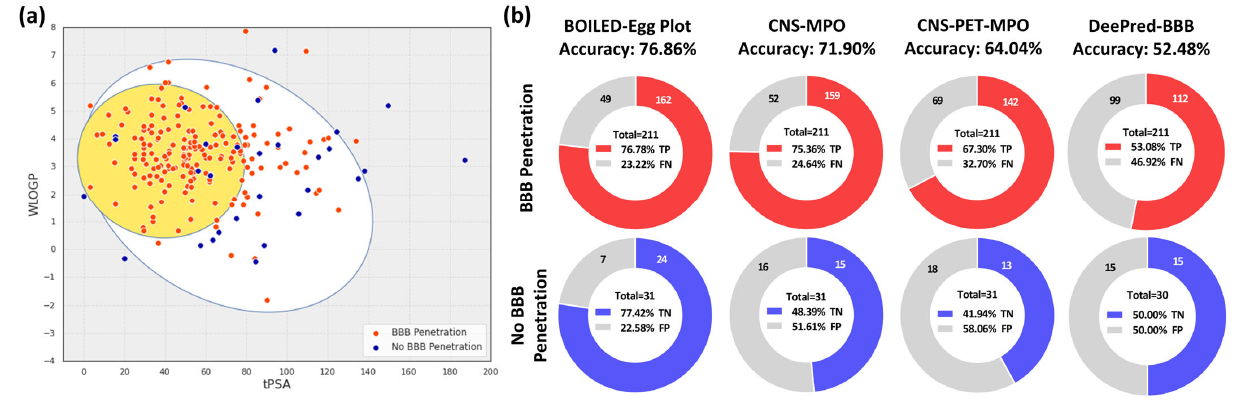
Figure 5. ( a ) BOILED ‐ Egg plot of the testing radiotracer dataset, including 211 BBB ‐ penetrated and 31 not BBB ‐ penetrated radioligands from the literature. ( b ) Pie charts of true positive (TP), false negative (FN), true negative (TN), and false positive (FP) rates for BOILED ‐ Egg plot, CNS ‐ MPO, CNS PET MPO, and DeePred ‐ BBB. The total number of not BBB ‐ penetrated compounds for DeePred ‐ BBB is 30 due to the conversion failure of one of the compounds from the program.